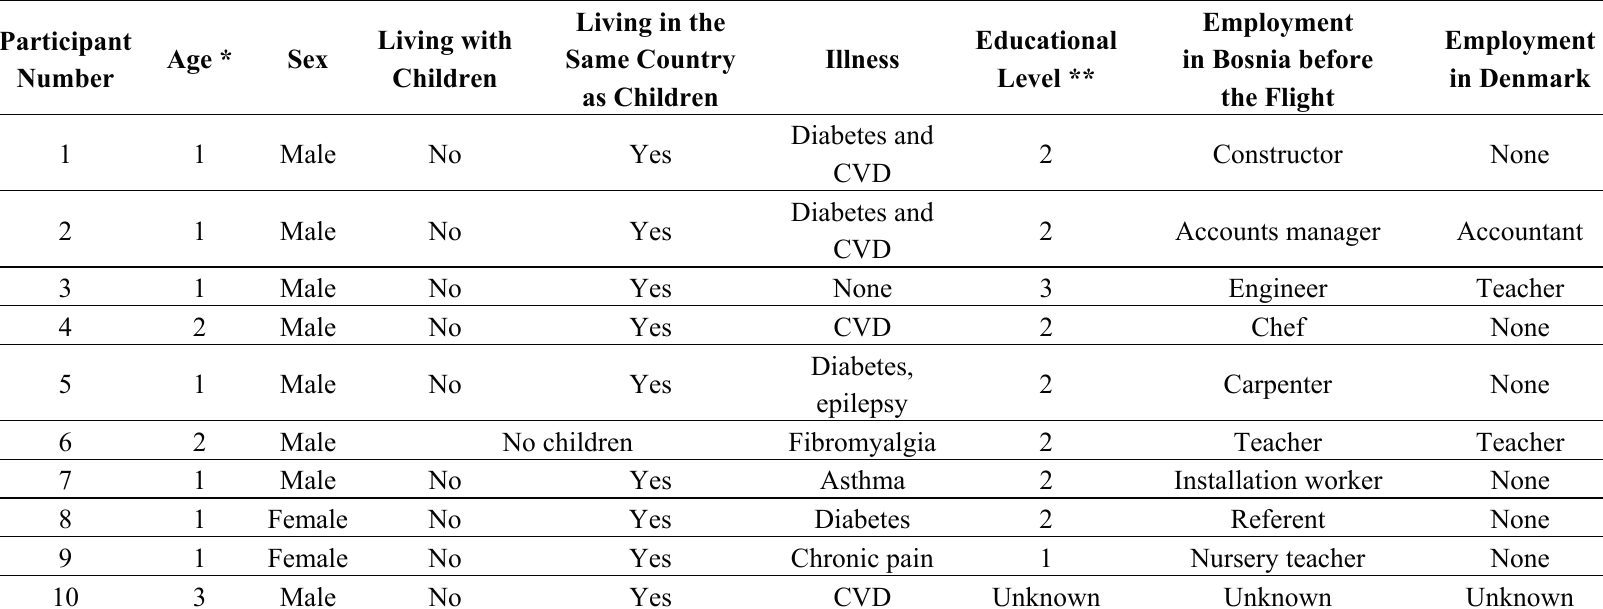
Table 1. Characteristics of informants residing in